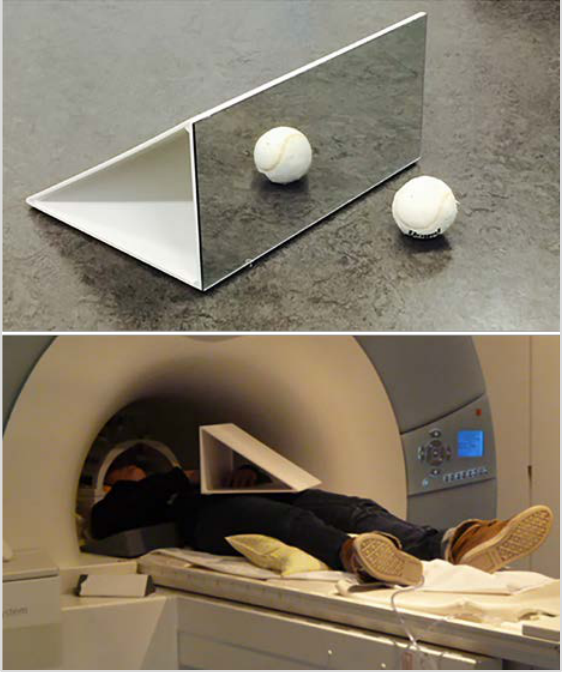
Figure 1: The experimental setting. A customised mirror box made out of plexiglas and wood was used for the experiment (left panel). Patients lay on their back in the scanner with their arms comfortably resting on the scanner table alongside their torso and with their elbows slightly flexed. A mirror was attached to the head coil above the head allowing the participants to view their hands (right panel).